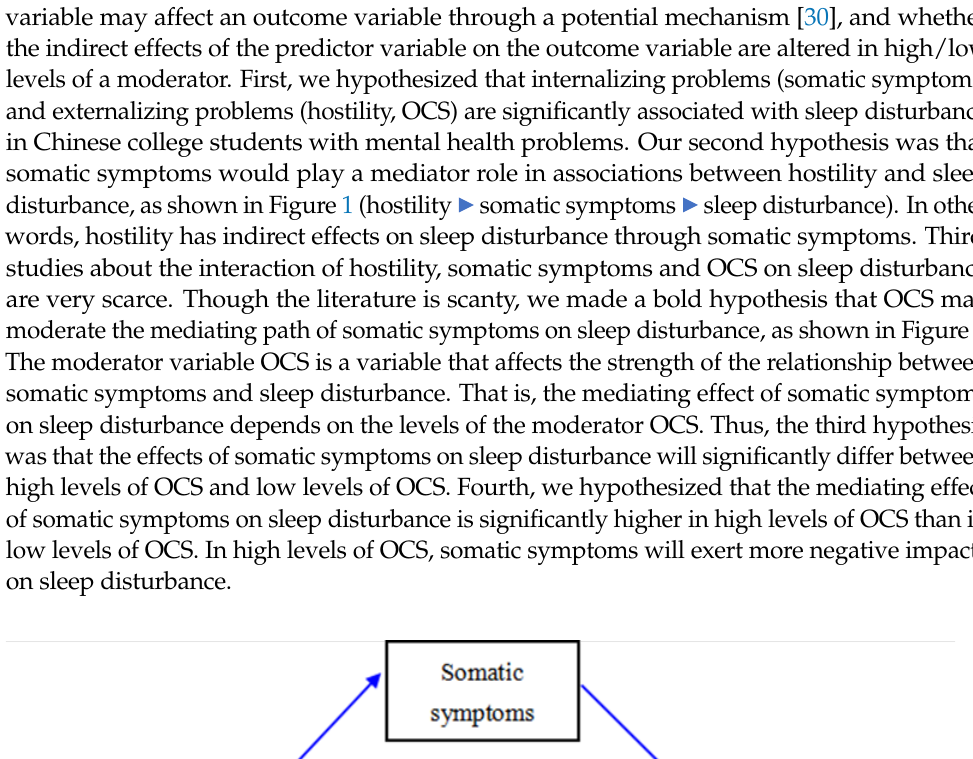
Table 1. Chinese college students ’ mental health screening scale and criteria .